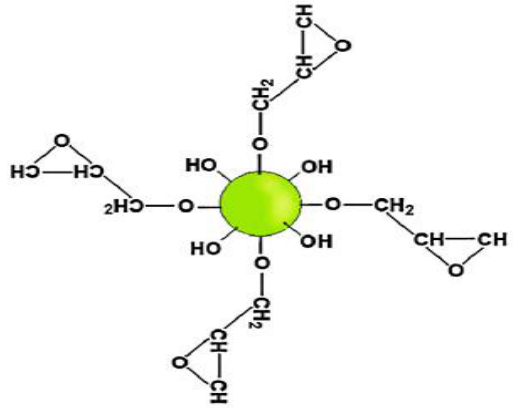
Fig. 2. The chemical structure of